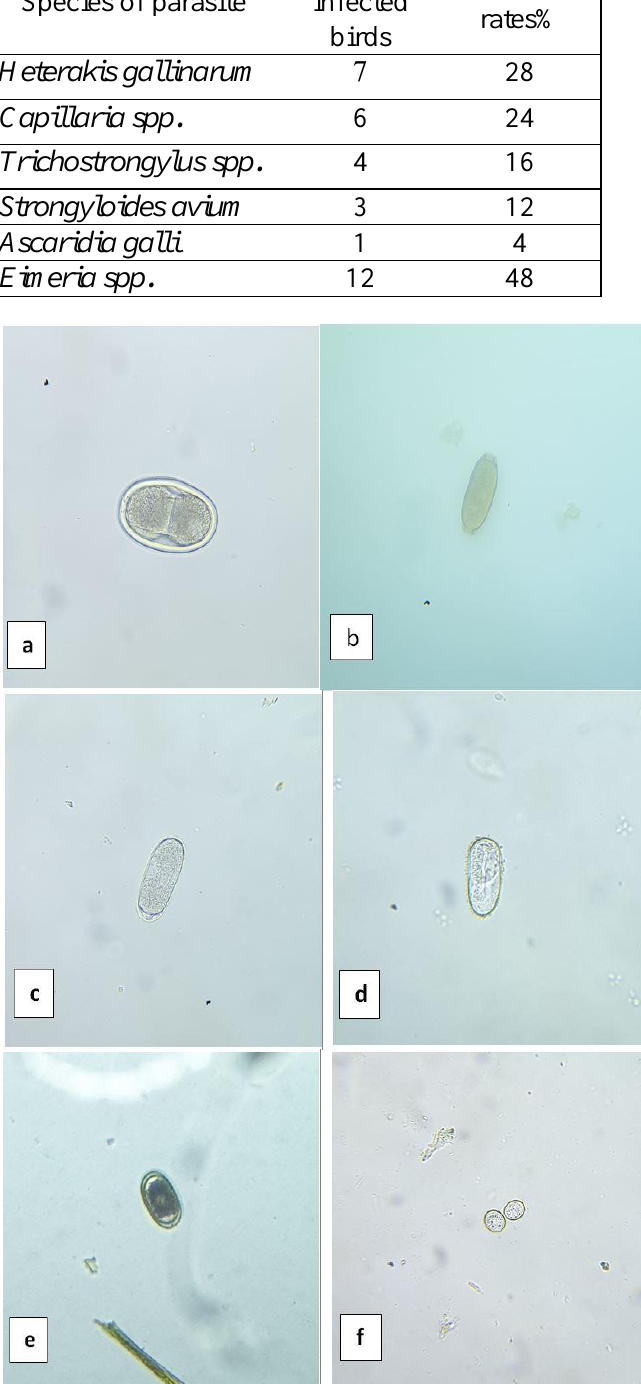
Fig. 1: Eggs of a. Heterakis gallinarum 40X, b. Capillaria spp. 40X, c. Trichostrongylus spp. 40X, d. Strongyloides avium 40X, e. Ascaridia galli 40X, f. Oocysts of Eimeria spp.